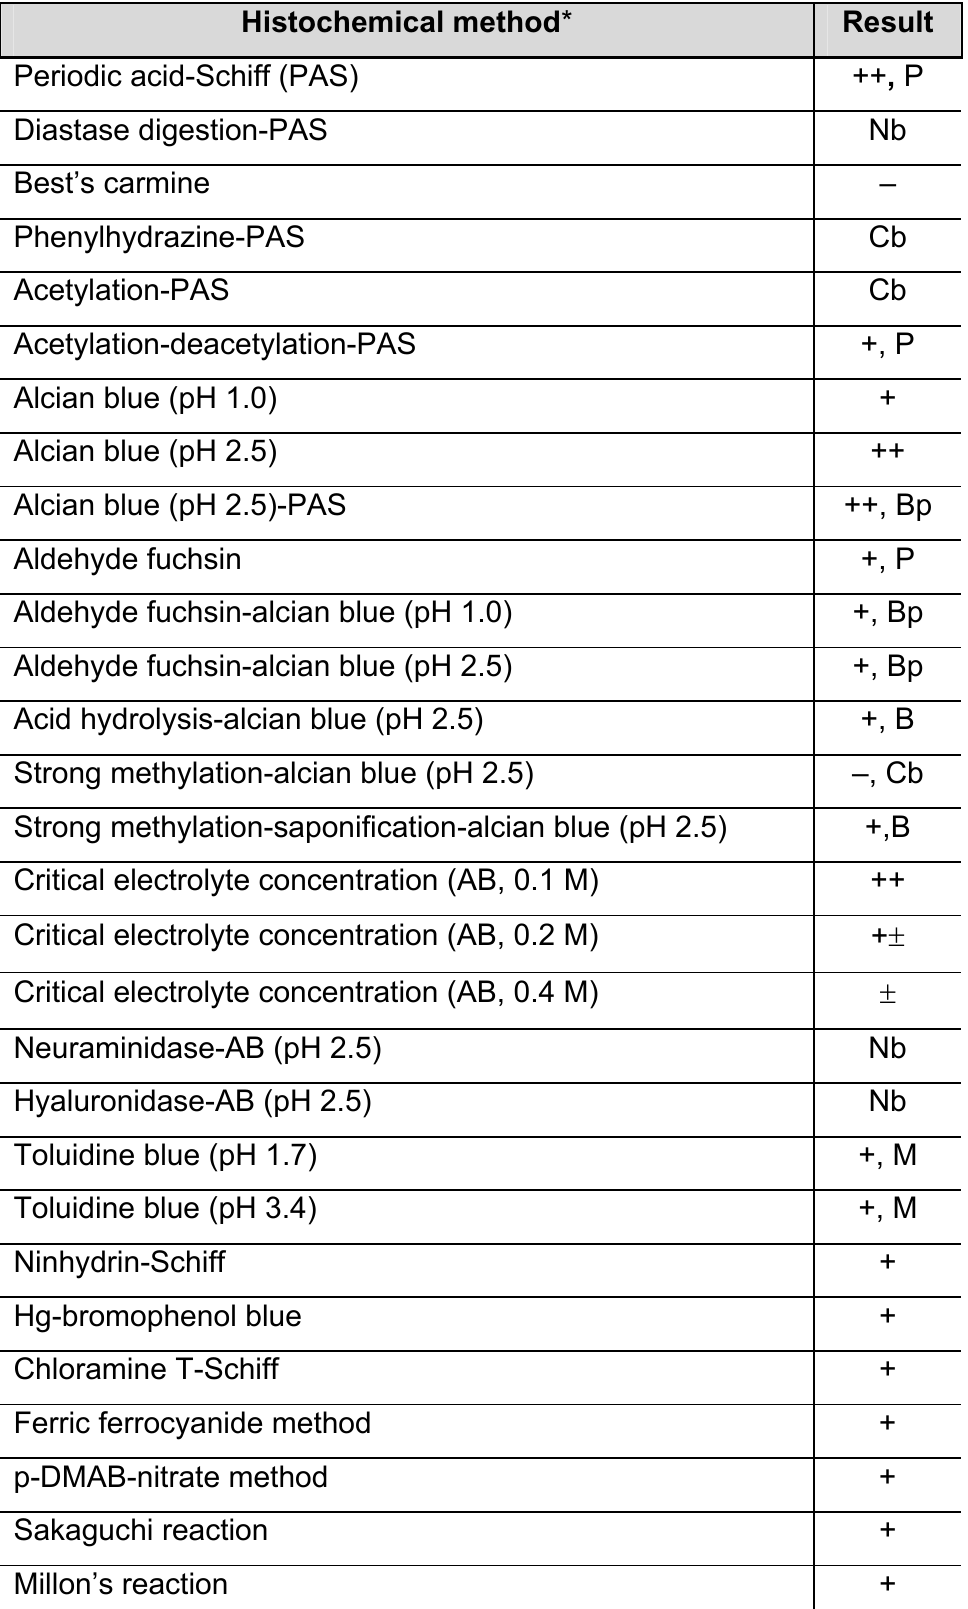
Table 1. Histochemical reactions revealed by the glandular epithelium in Androctonus crassicauda venom apparatus Histochemical method *